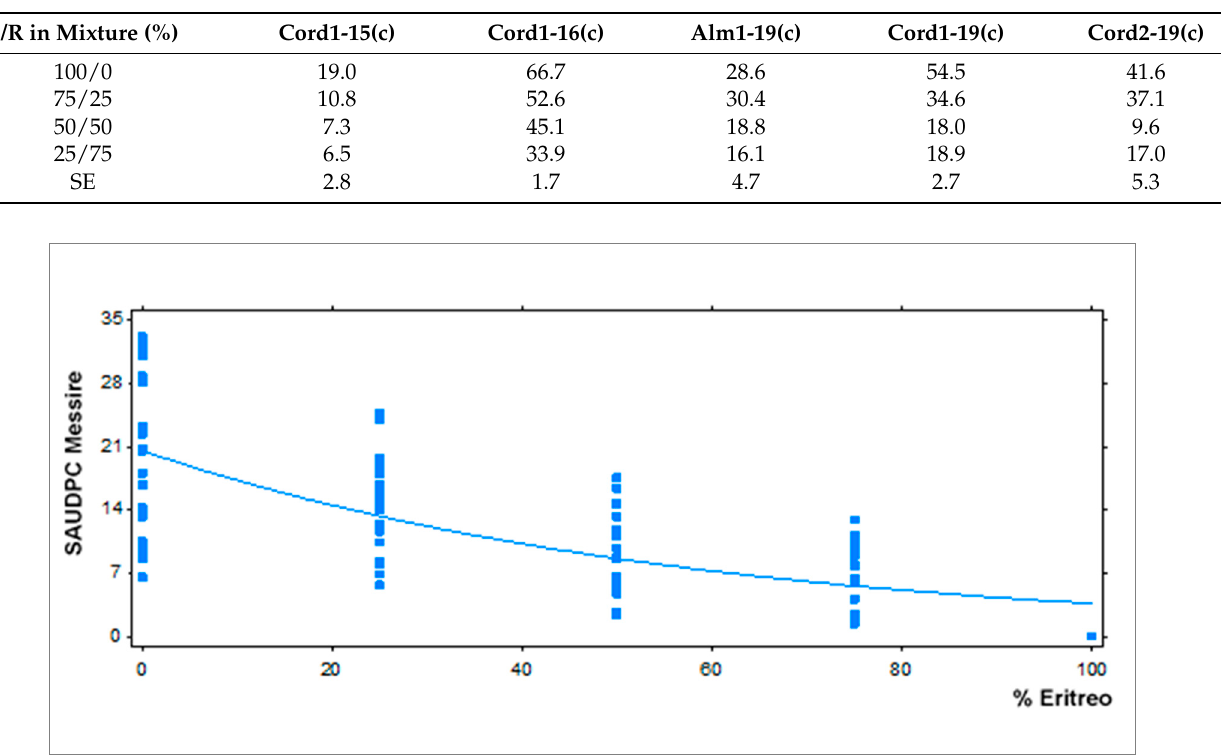
Figure 7. Nonlinear regression fitted curve for powdery mildew SAUDPC in susceptible cultivar Messire with varying